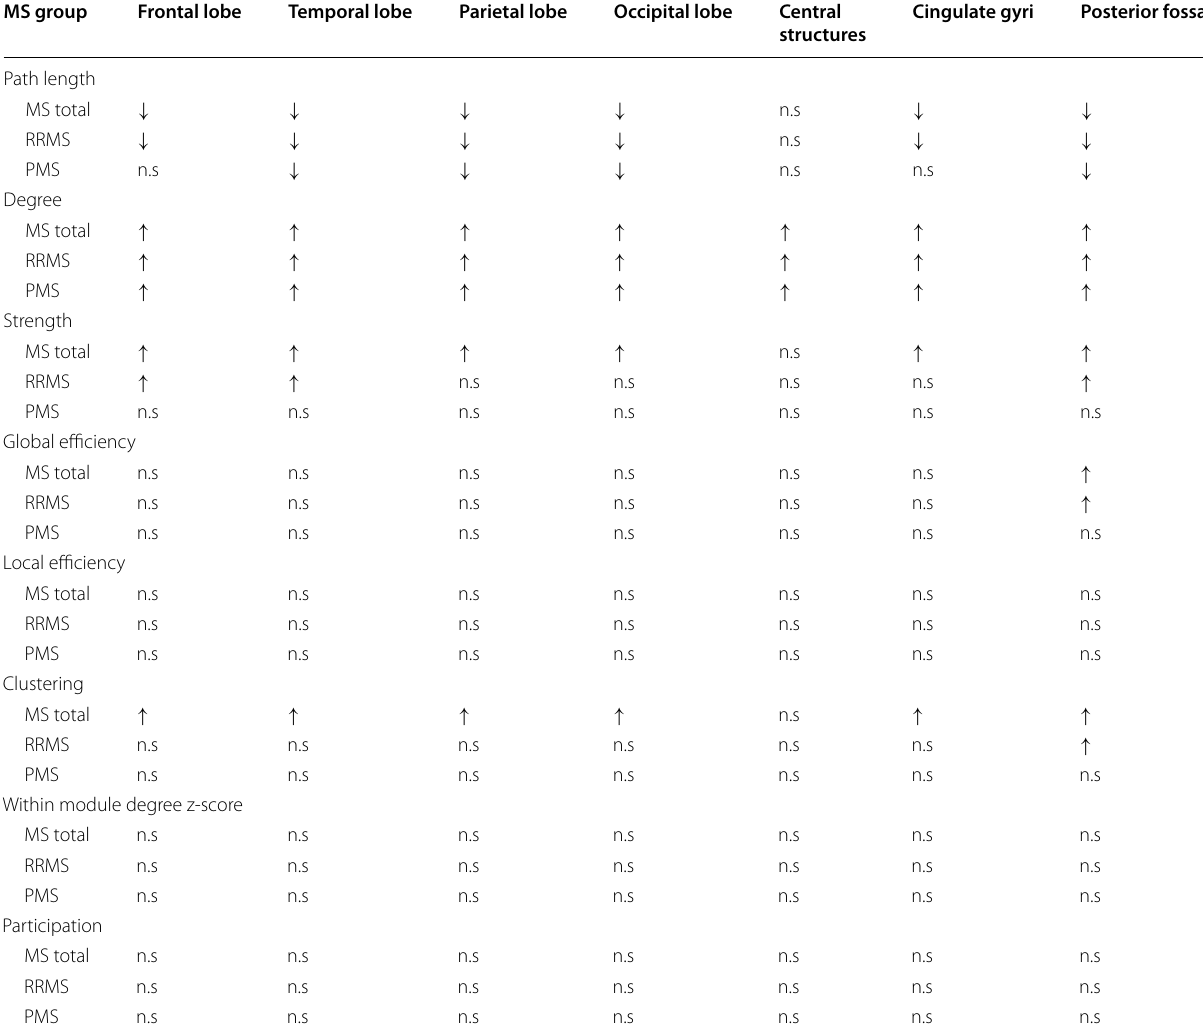
Table 4 Compilation of regional differences in network topology derived from lesion‑filled T1w MRI images. The results for the comparisons of the different MS groups with healthy controls are provided. The comparison RRMS versus PMS did not yield any significant